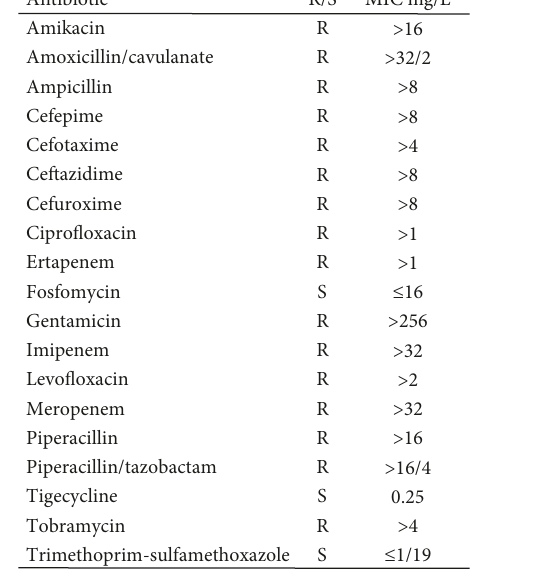
Figure 3: Antibiotic susceptibility according to the European Committee on Antimicrobial Susceptibility Testing (EUCAST) clinical breakpoints of clinical Klebsiella pneumonia isolate. MIC: minimum inhibitory concentration; R: resistant; S: